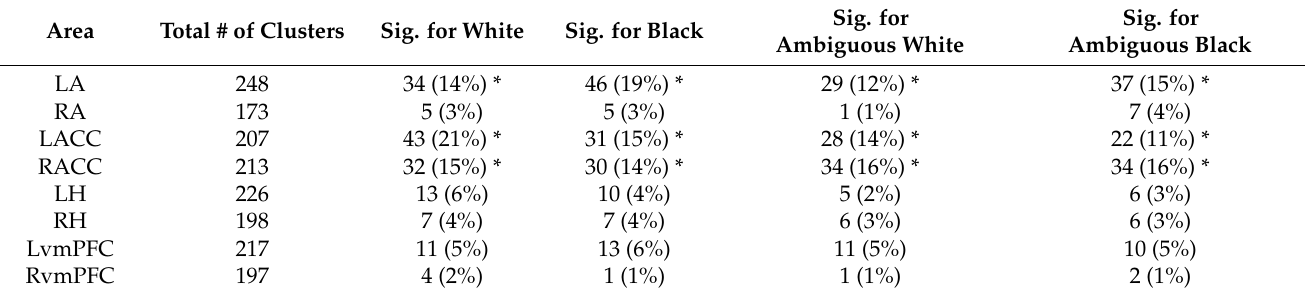
Table A5. Clusters (MUA) significant for specific race categories (relative to background firing) by side and brain area across all patients ( n = 13), as indicated by multinomial logistic regression models. Values with asterisks denote significant proportions in binomial tests ( p < 0.05), after correction for multiple